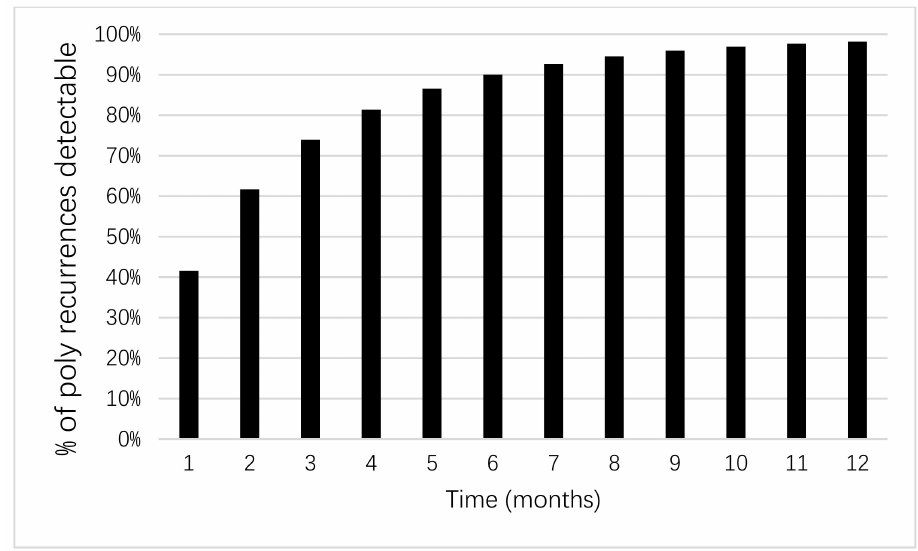
Figure A2. Time required for oligo+ to become distinguishable as poly-recurrent disease. This is estimated as the time that the 4th metastasis passes the detection threshold. 73.8% of oligo+ metastases become detectable after 3 months, and 98.2% of the oligo+ becomes detectable after one year. Data is based on the extrapolation of the microsimulation-model. Table A1. Proportion of oligo+ within patients with detected oligo-metastases in the M total Lower scenario. Asymptomatic Symptomatic